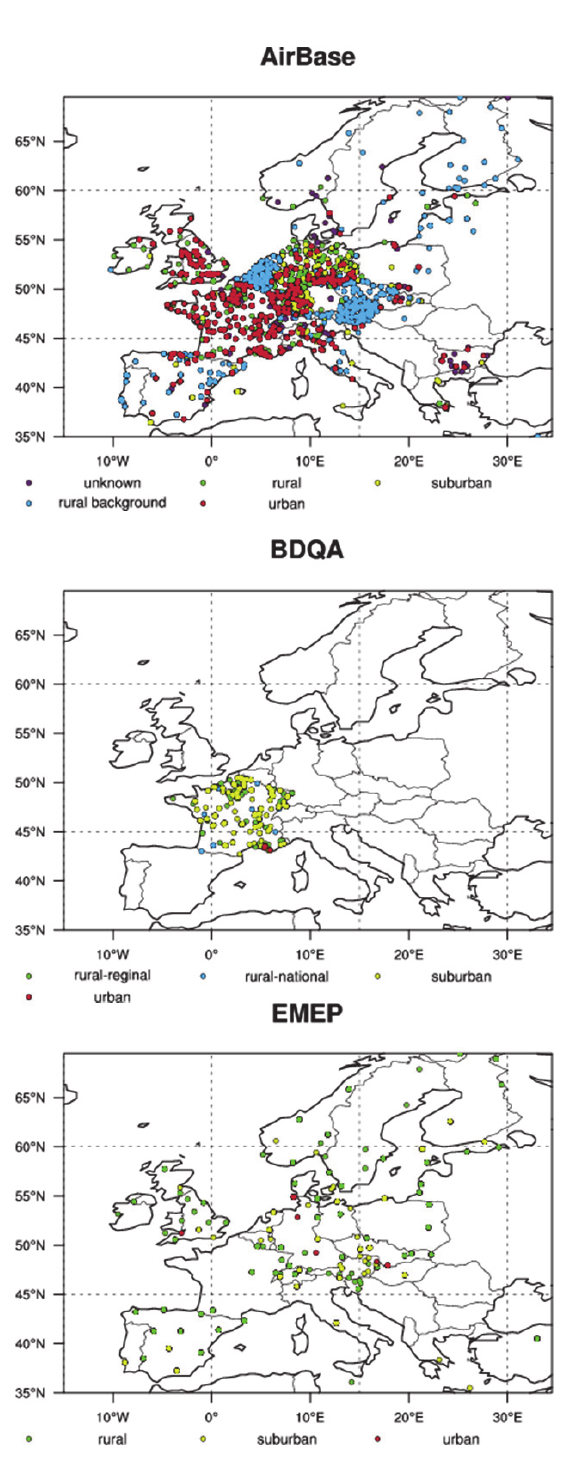
Figure 2. Observational data from the three networks: AirBase, BDQA, and EMEP used in Fig. 2. Observational data from three networks: AirBase, BDQA, model evaluation. and EMEP used in model